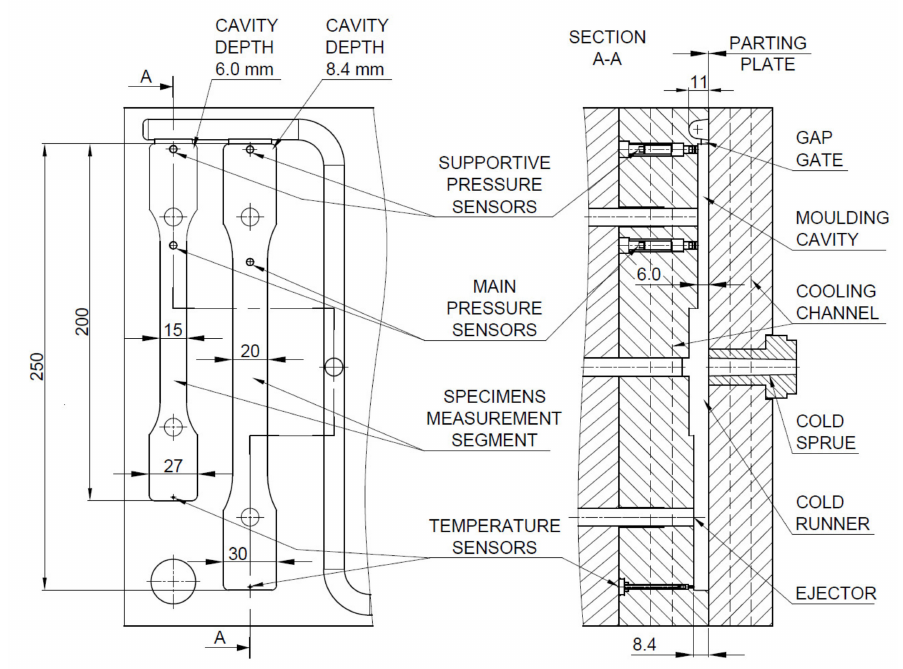
Figure 3. Cavities dimensions and sensors positions inside the special injection mold. All dimensions are in mm.